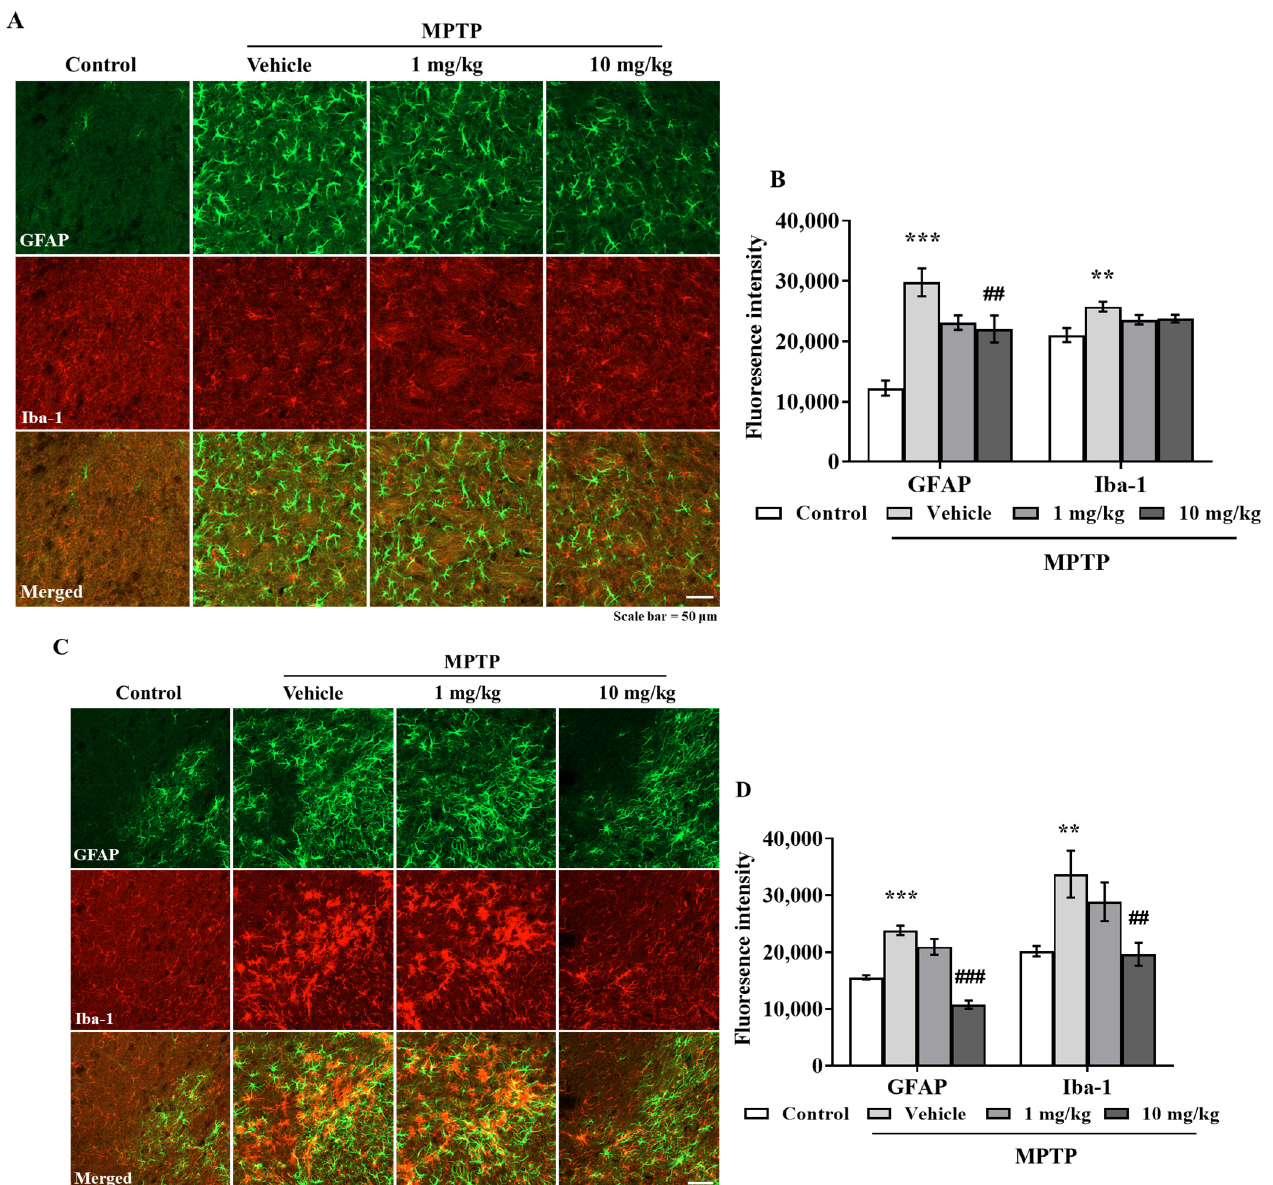
Figure 6. MHY2699 repressed MPTP-induced glial activation in the nigrostriatal pathway. ( A , C ) STR ( A ) and SN ( C ) sections were double immunostained using anti-GFAP (green) and anti-Iba-1 (red). Scale bar = 50 µ m. ( B , D ) Quantitative analyses of GFAP and Iba-1 intensities in the nigrostriatal pathway. The results are presented as means ± SEs ( n = 3–5 mice/group). *** p < 0.001, ** p < 0.01, vs. naïve controls, ### p < 0.001, ## p < 0.01 vs. the MPTP treated group (as determined by ANOVA with Tukey’s multiple comparisons).